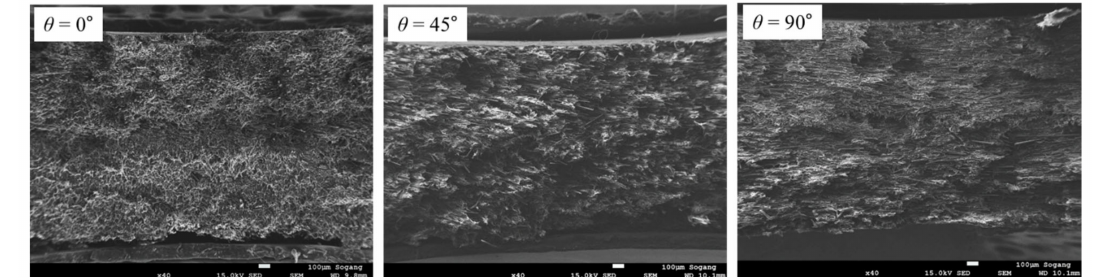
Figure 13. Fracture surfaces observed for compressive specimens with a strain rate of 0.001 s − 1 (magnification: × 40, scale: 100 µ m).